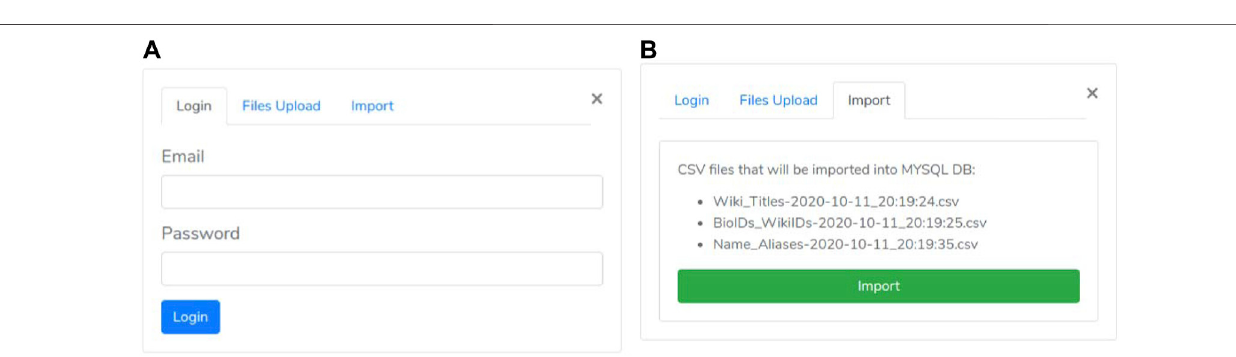
FIGURE 4 | Authentication and Import panel. (A) Authentication panel; (B) Import